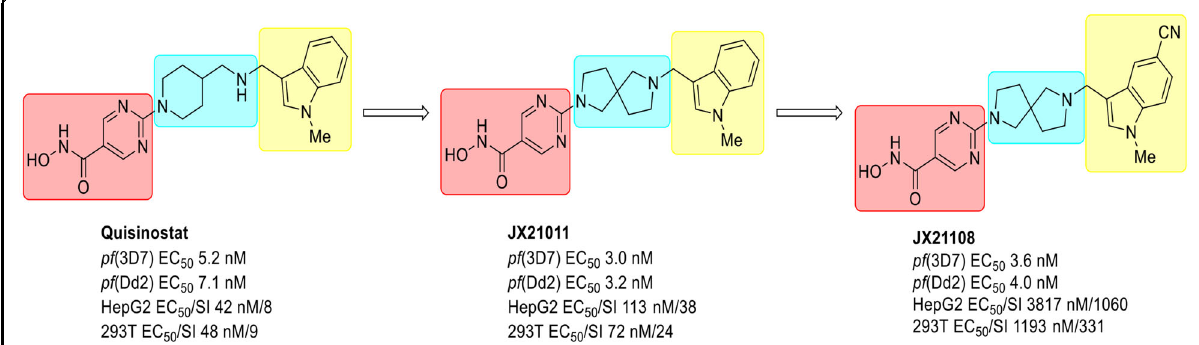
Fig. 1 Chemical evolution of JX21108 from quisinostat. SI, selectivity index, which was calculated by the EC 50 for HepG2 or 293T/EC 50 for 3D7, a drug-sensitive strain of P. falciparum . Dd2 is another P. falciparum strain resistant to several antimalarial drugs, including me fl oquine, pyrimethamine, and